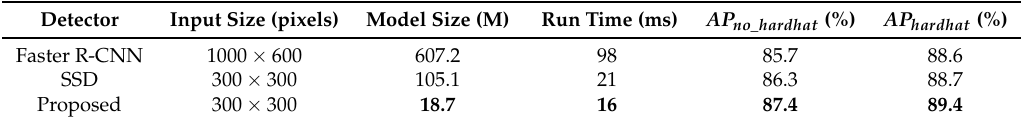
Table 3. Results comparison with other object detection methods (bold indicates either best performance or minimum